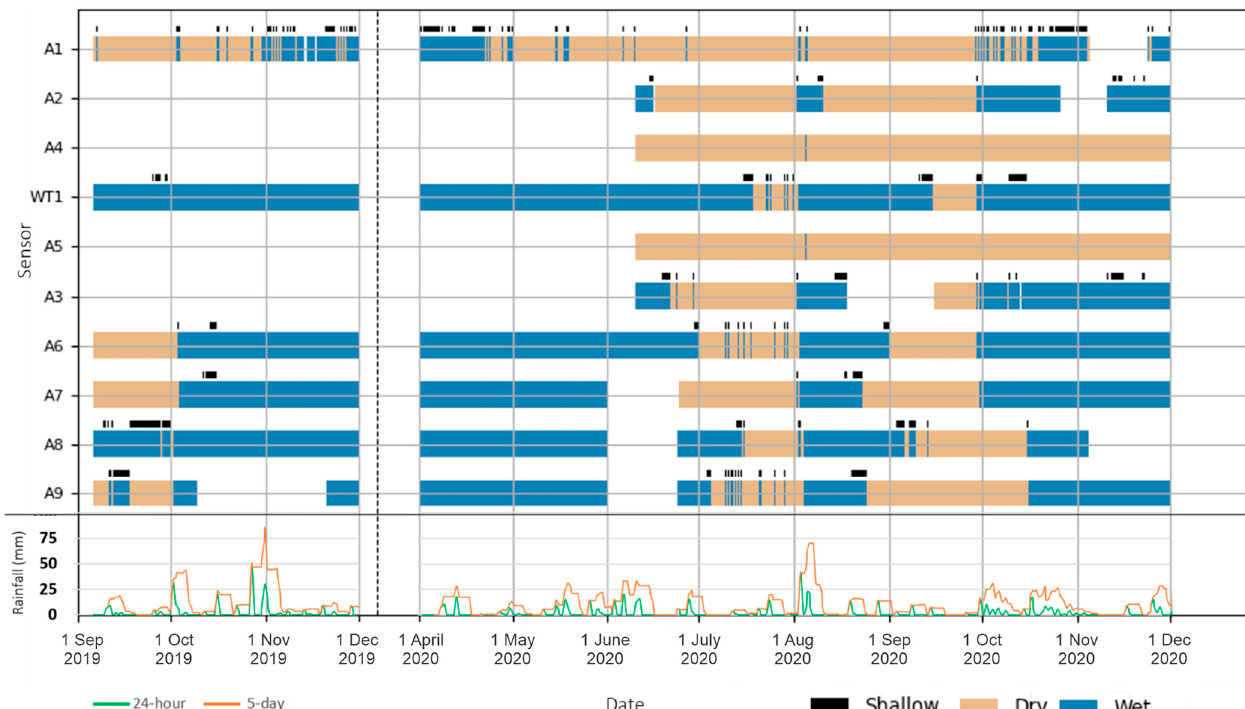
Figure 4. Top panel: Timeline bars of the 2019 and 2020 study periods indicating when a monitoring station is wet (blue) or dry (brown). Time steps are at 1000 h and 1600 h. Thin black bars above each timeline represent when the corresponding station water level was between 0.02 m and 0.05 m, signifying time periods when the station had shallow water. The dashed vertical lines indicate the break in the data between 30 November 2019 and 1 April 2020. Missing data are shown as gaps. Bottom panel: Cumulative rainfall over the previous 24 h (green line) and 5 days (orange line) for each 1000 h and 1600 h time step.